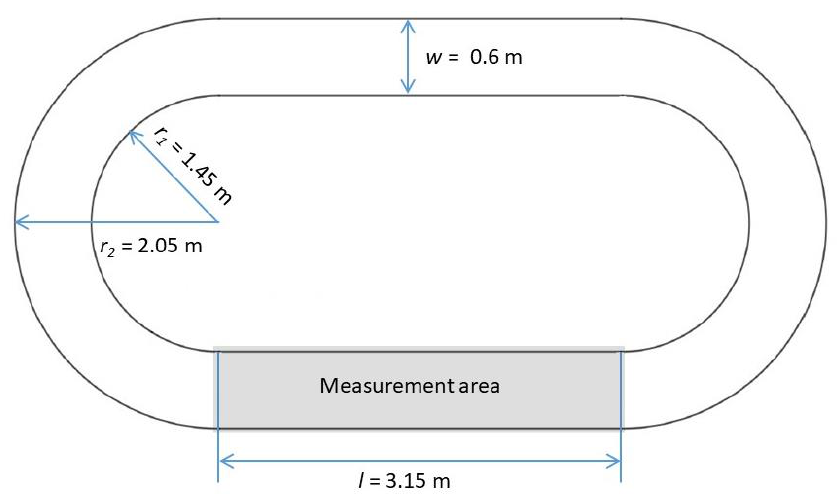
Figure 1. Schematic representation of the experiment setup (redrawn from Subaih et al. [40]).